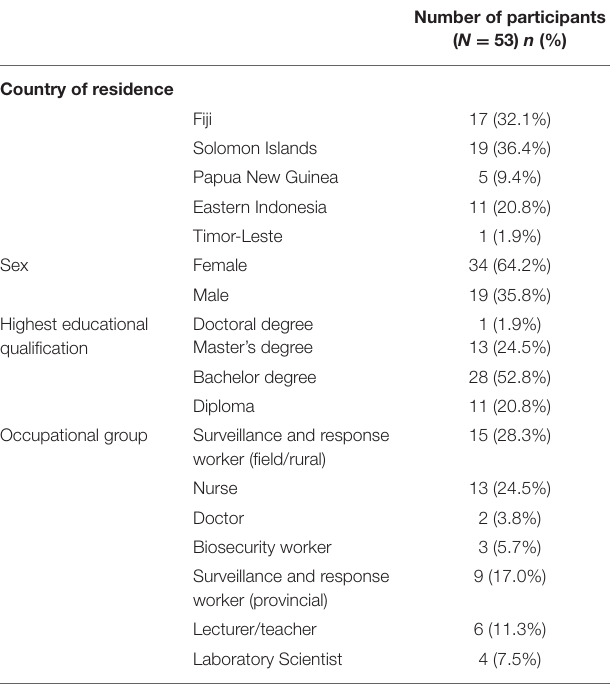
TABLE 1 | Demographic characteristics of completed Research